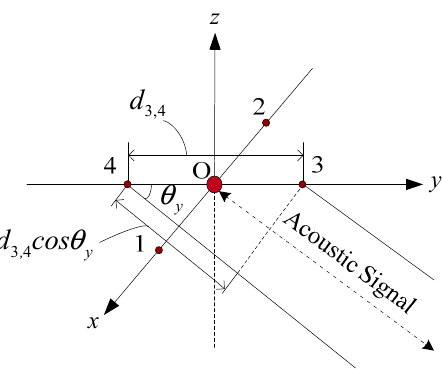
Figure 3. Diagram of the USBL phase difference.